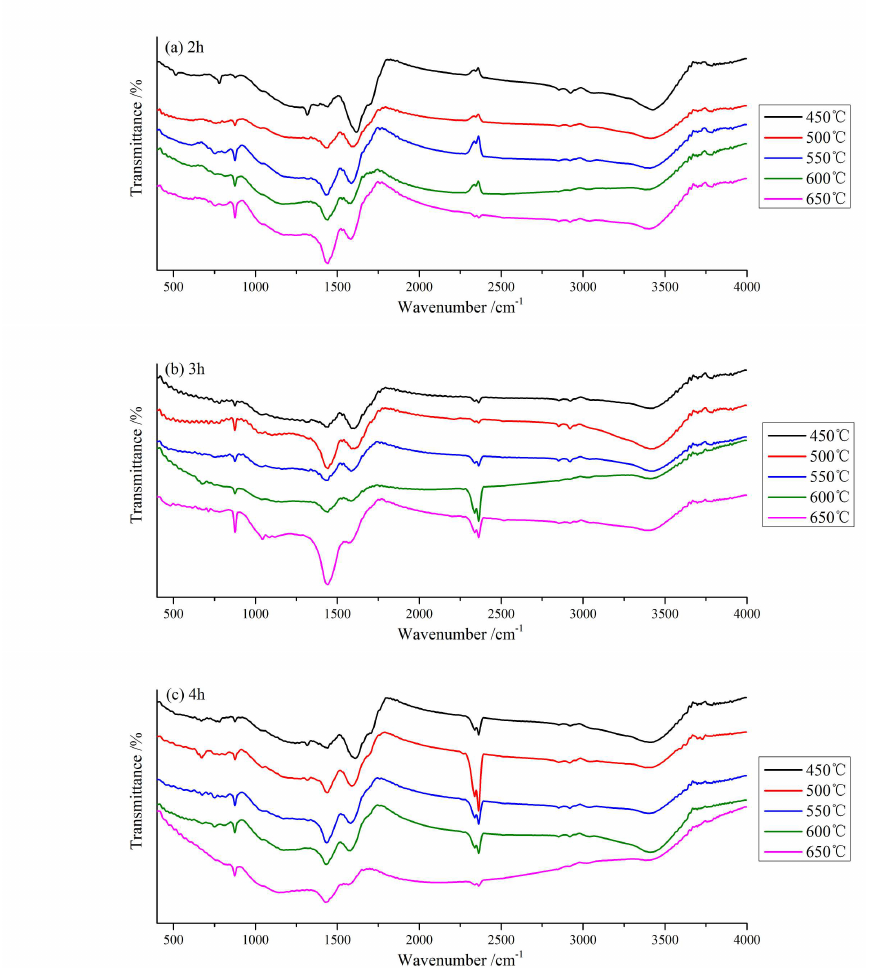
Figure 6. FTIR spectrograms of CB at di ff erent pyrolysis processes. ( a ) 2 h; ( b ) 3 h; ( c ) 4